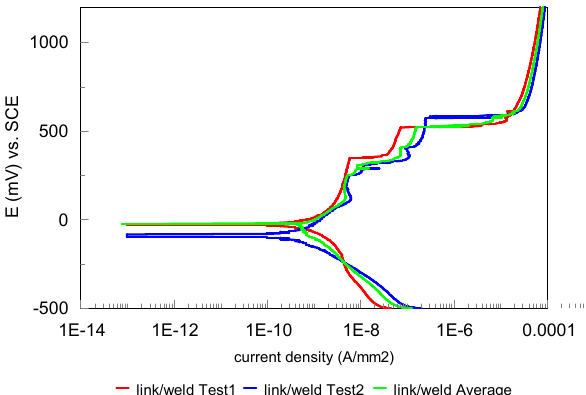
Figure 10. The potentiodynamic polarization curves measured for the interface link/weld area of the transverse surface and the average curve obtained from the experimental curves. Sample #8.